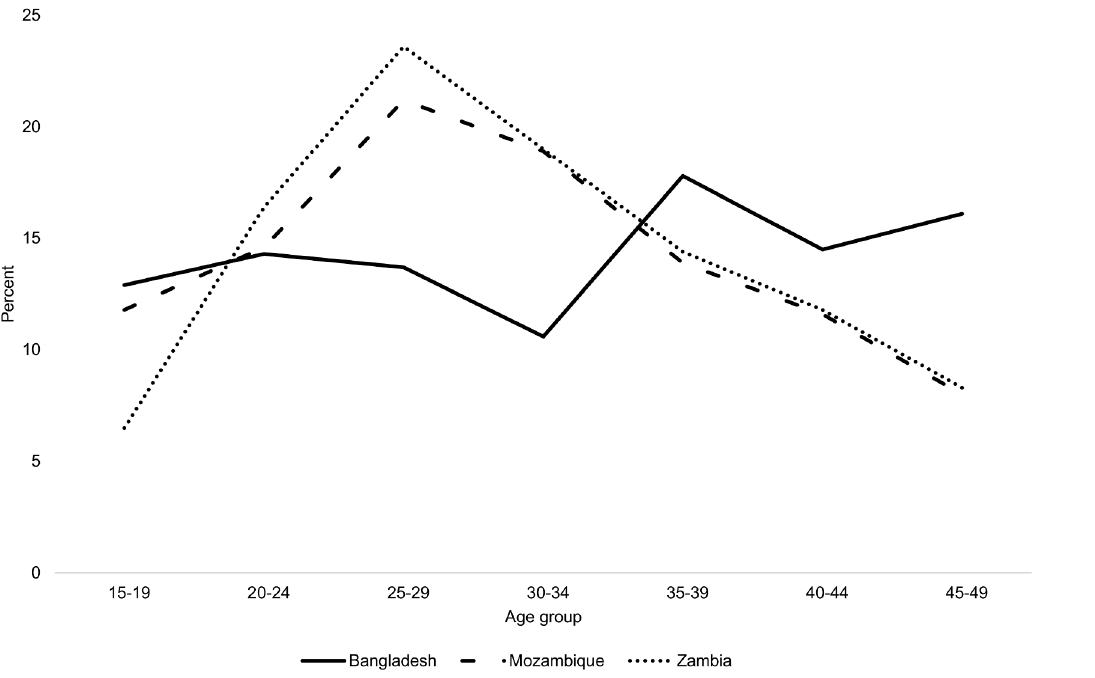
Fig 1. Distribution of deaths among women aged 15 – 49 by age group and country, weighted.